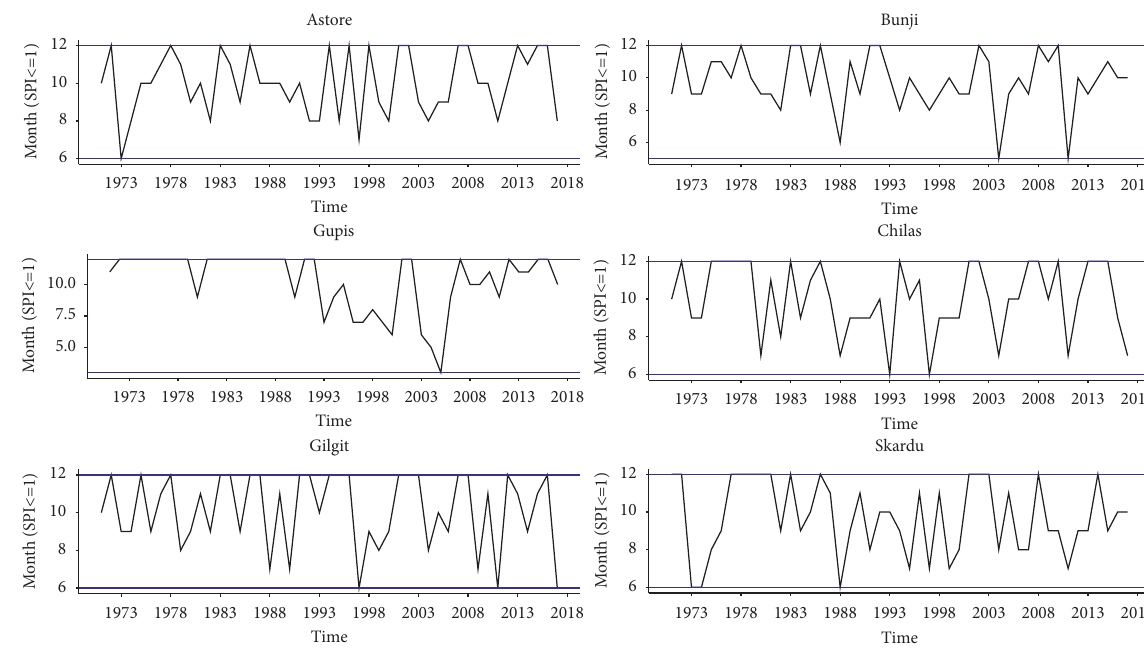
Figure 4: Time series plot: temporal behavior of SPI ≤ 1 in selected